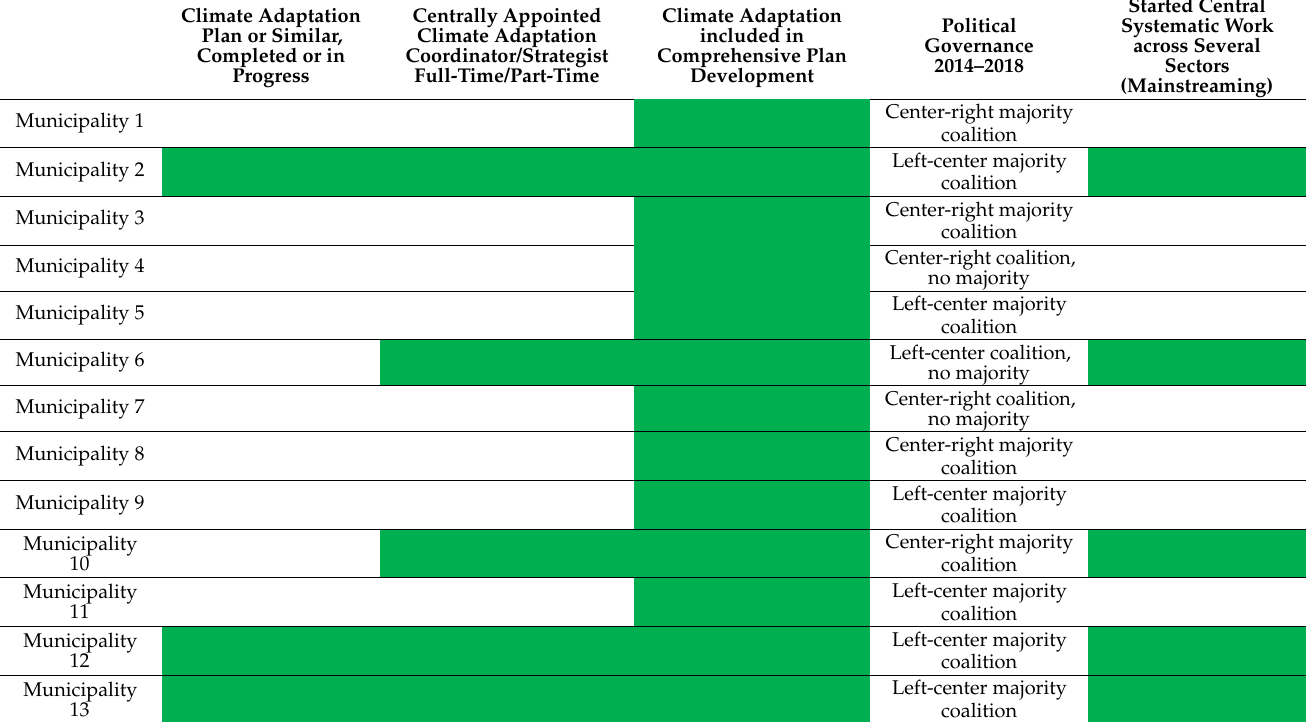
Table 1. Summary of climate adaptation organization in the municipalities (Spring